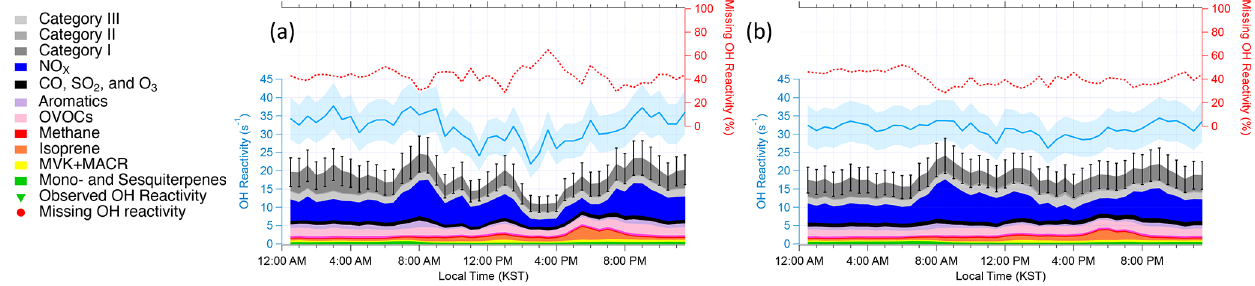
Figure 3. Diurnal averages of OH reactivity during (a) the stagnation period from 17–22 May 2016 and (b) the transport period from 28 May–1 June 2016. The measured and calculated OH reactivity are on the left. The blue shading represents an uncertainty of 16.7% at 1 σ . The black bars represent the propagated uncertainty of 20.1% at 1 σ from calculated missing OH reactivity. The percent of missing OH reactivity is on the right axis.